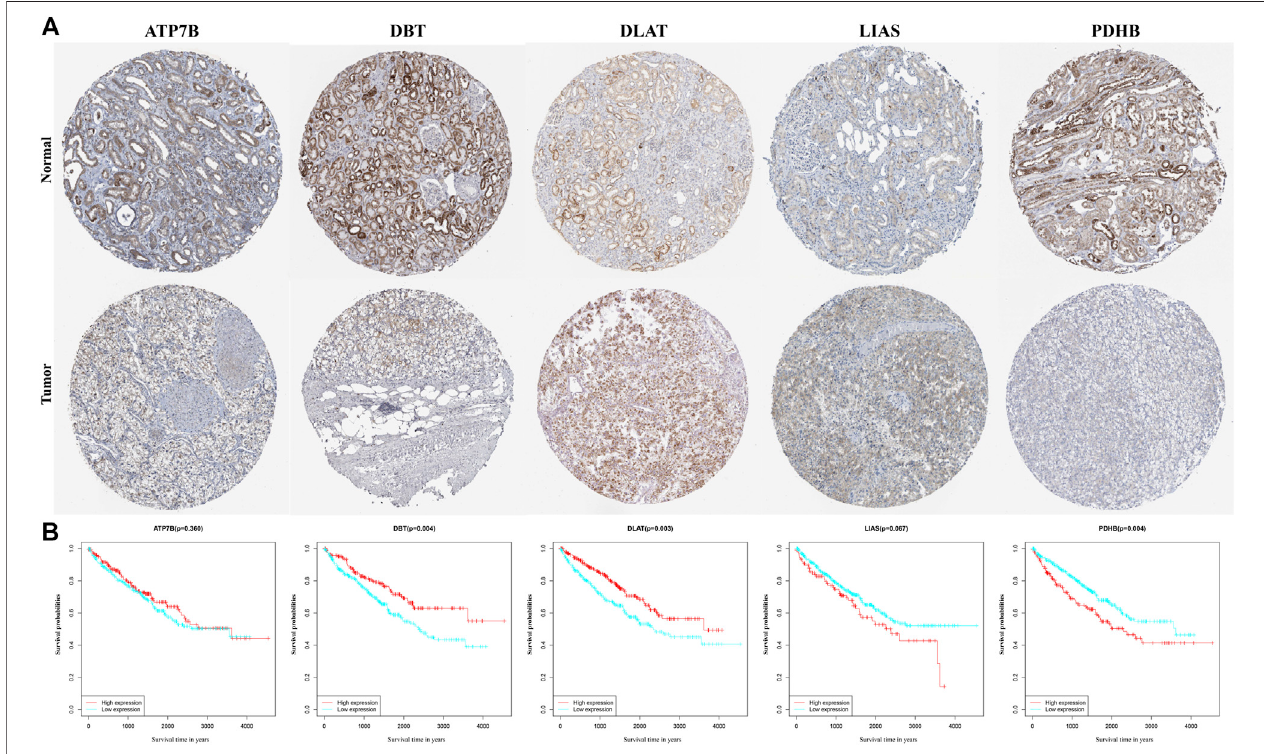
FIGURE 5 | Validation of each gene in the gene signature. (A) Levels of expression of genes, as determined immunohistochemically, in samples from the Human Protein Atlas database. (B) KM curves for OS of ccRCC patients based on the expression of genes.